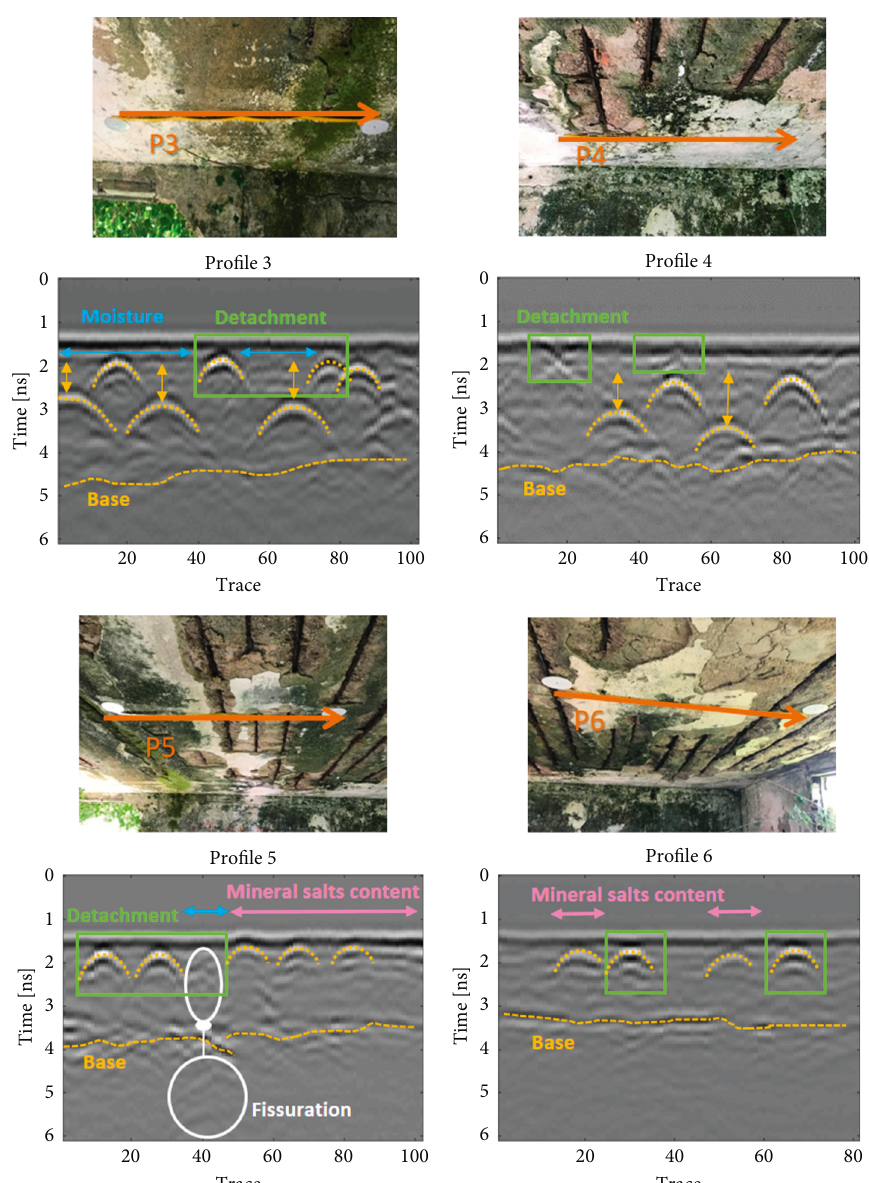
Figure 5: GPR results showing the interpretation of the pathologies identified (modified from